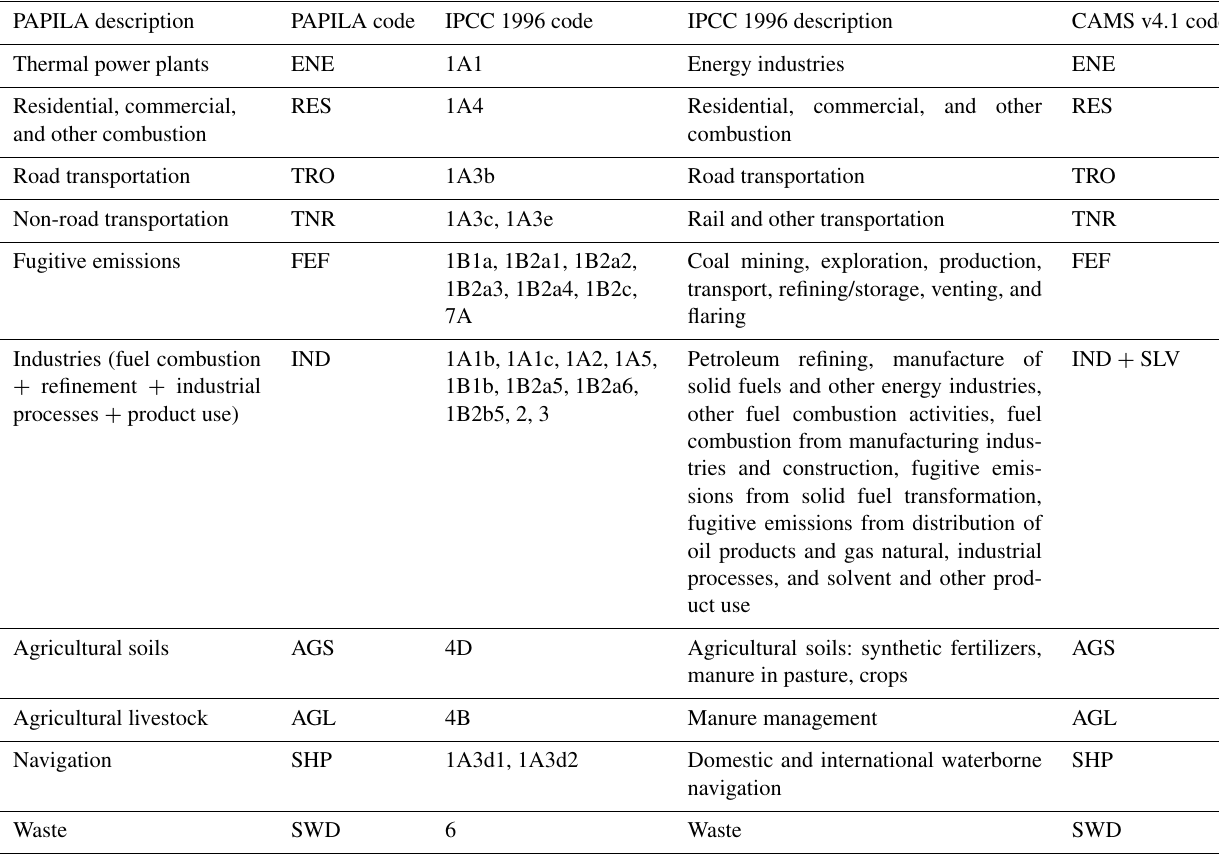
Table A1. Description of categories and codes considered in the PAPILA inventory and their equivalence with those of CAMS. PAPILA